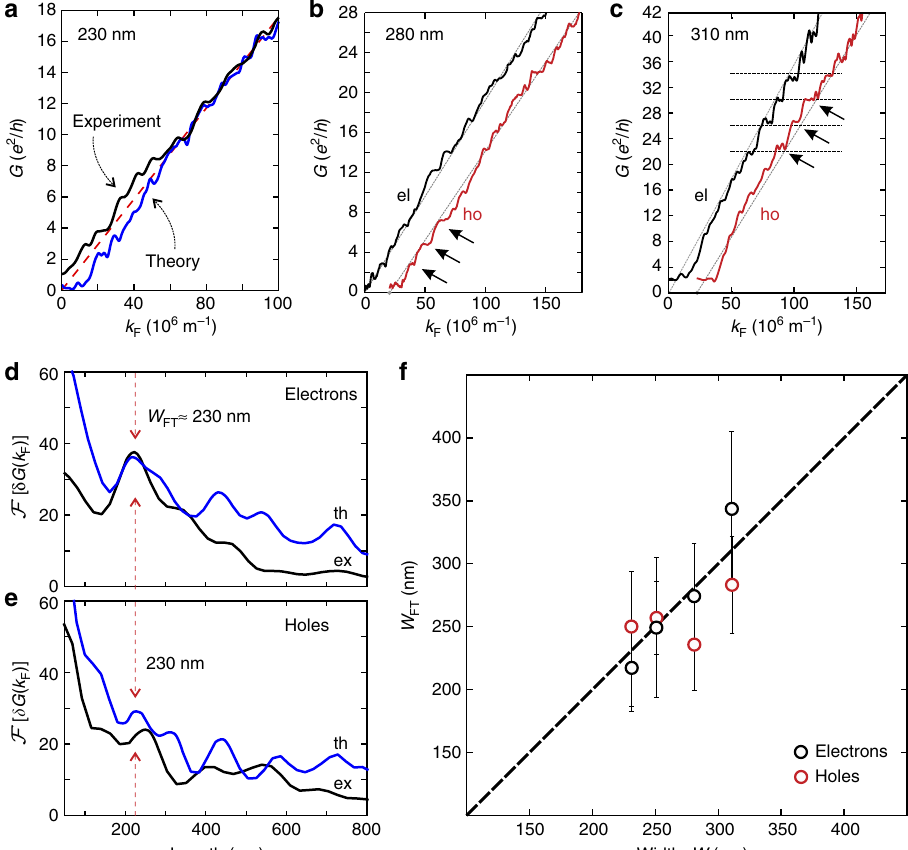
Figure 3 | Size quantization signatures. ( a ) Comparison of the low-energy conductance between theory (blue) and experiment (black). ( b , c ) Measured electron (el; black trace) and hole (ho; red trace) conductance including kink or step-like structure (see arrows) as a function of k F for two different constriction widths (see insets). The hole conductance traces are horizontally offset for clarity. ( d ) Fourier transform of the G (cid:3) G (0) electron conductance F½ d G ð k F Þ(cid:5) through the 230-nm graphene constriction, for experiment (ex; black trace) and theory (th; blue trace). The first peak of the Fourier transform clearly corresponds to the width W of the quantum point contact (marked by arrows). ( e ) Same as d for the hole conductance. The size of the first peak is substantially reduced for both experiment and theory due to the presence of localized states that lead to additional scattering. ( f ) Comparison of width W FT extracted from the Fourier transform of the conductance traces (as shown in d , e ) to geometric constriction width W from four different devices (extracted from SEM